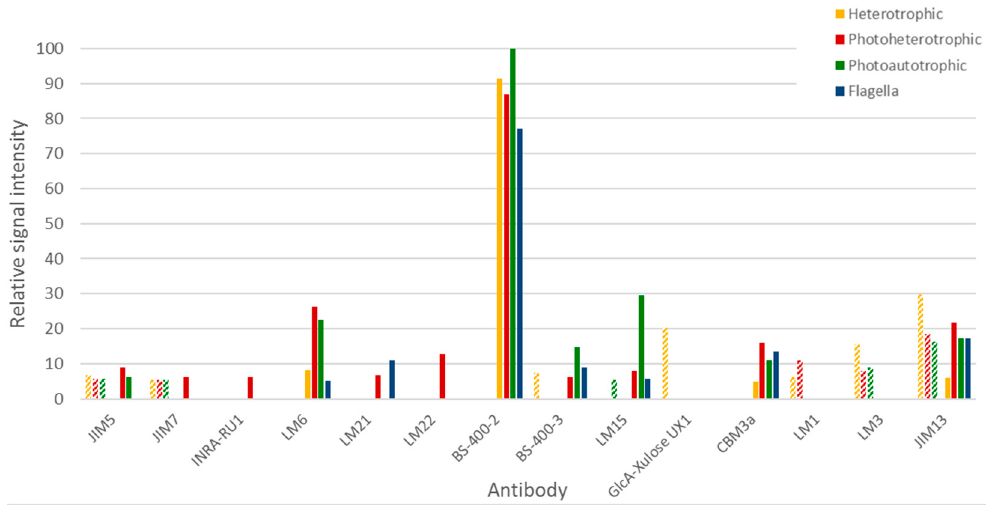
Figure 4. Immunocarbohydrate microarray profiling of Euglena samples . Only those antibodies that had some reactivity to the Euglena samples are presented and a full list of the antibodies used and their specificity are presented in Table S3, Supplementary Materials. Hashed bars represent CDTA released material and solid bars represent NaOH released material. Signal is normalised to the strongest signal.